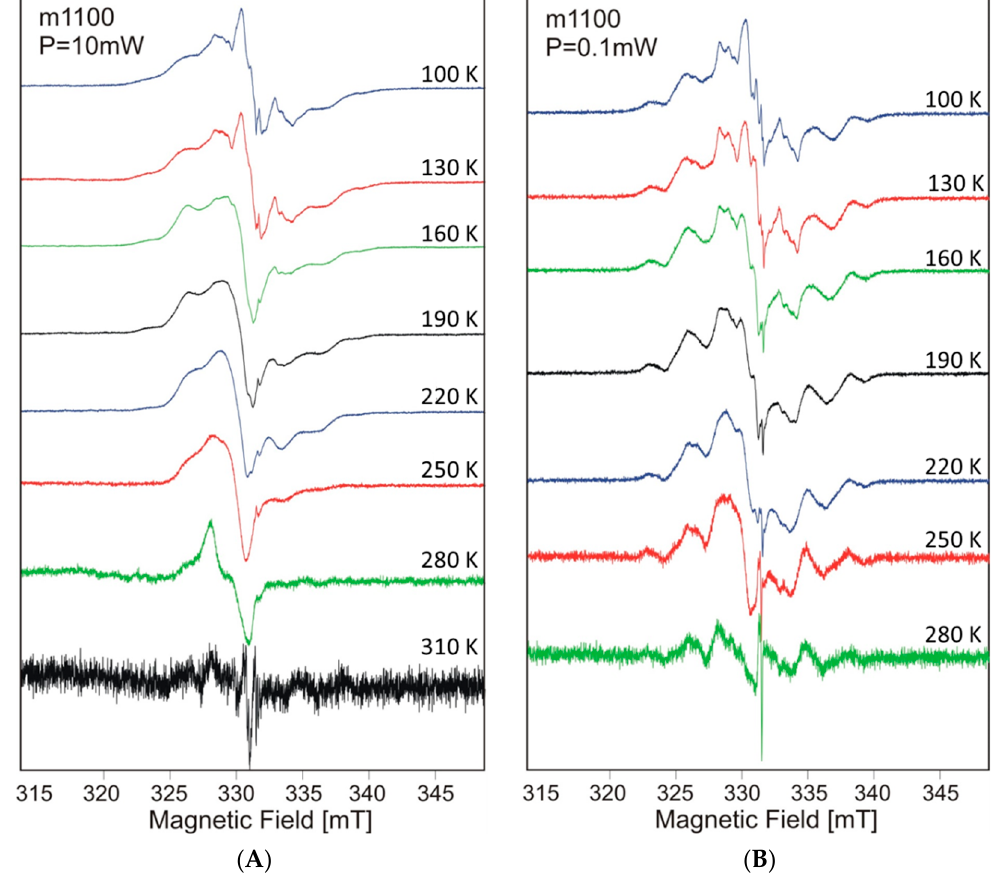
Figure 1. The spectra for unaged tapes made of unprotected XLPE after probe-irradiation with a 10 kGy dose of gamma radiation and subsequent cryogenic EPR measurement with annealing. The spectra were recorded in the microwave powers of 10 ( A ) and 0.1 mW ( B ), respectively, in the temperatures 100–310 K.